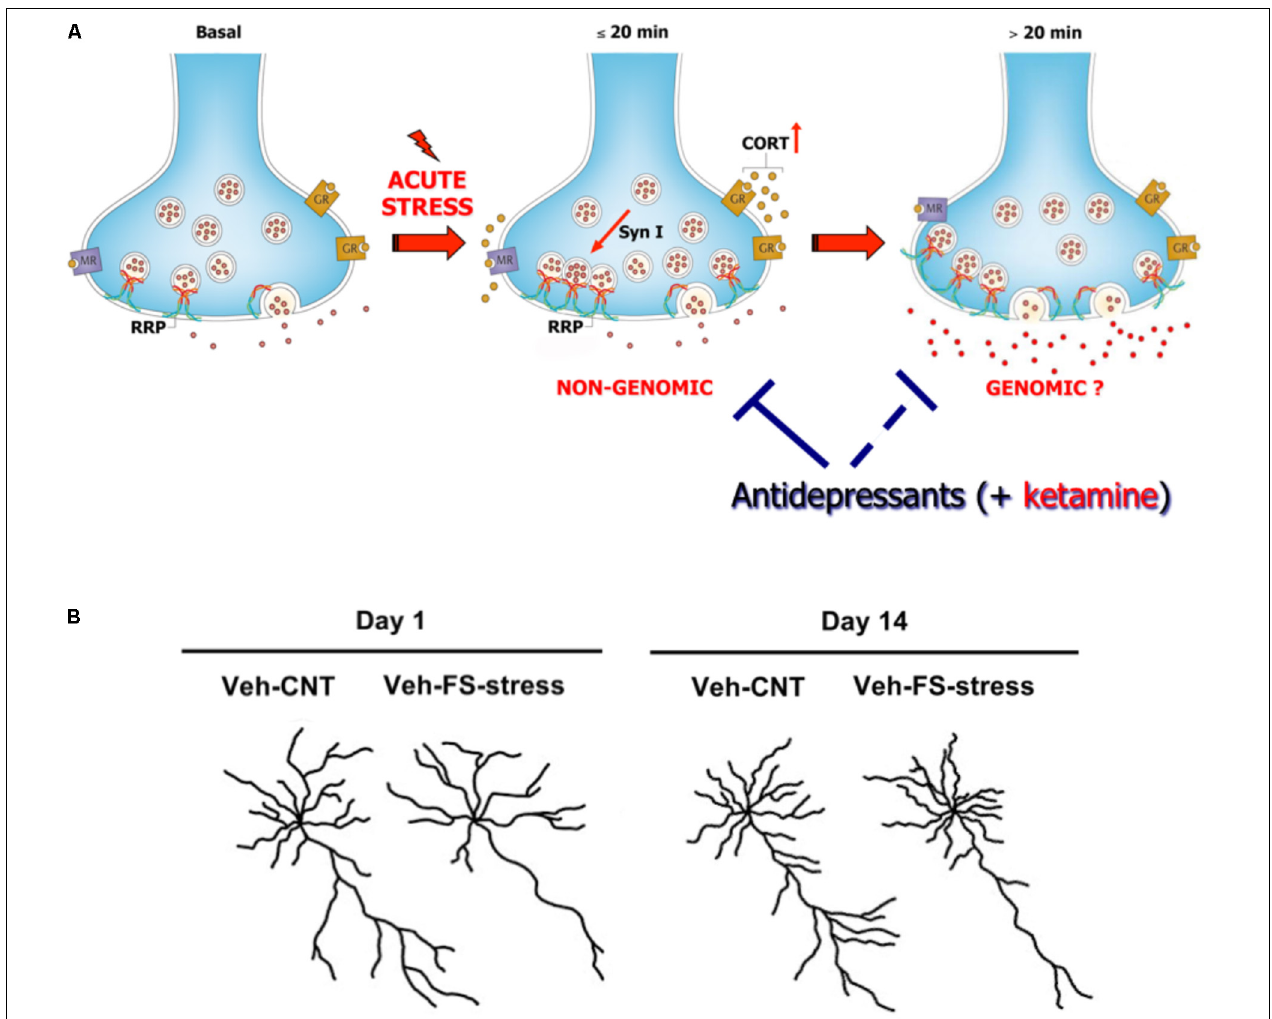
FIGURE 2 | (A) Acute stress increases circulating levels of CORT that binds to local synaptic mineralocorticoid/glucocorticoid receptors. This in turn induces, in synaptic terminals of prefrontal and frontal cortex, a rapid increase of vesicle trafficking into the readily releasable pool (RRP) of glutamate vesicles, with consequent increase of RRP size ( < 20 min). This implicates non-genomic mechanisms, in particular phosphorylation of the presynaptic protein synapsin I at Ser 9 . The increase of RRP size, rapidly induced by CORT, primes the terminals for the subsequent enhancement of depolarization-evoked glutamate release. This was shown by in vitro incubation of purified synaptic terminals (synaptosomes) with CORT, which replicates the increase in the size of glutamate RRP and synapsin I phosphorylation. Slower ( > 20 min), perhaps partly genomic, effects are required to promote the enhancement of glutamate release and excitatory transmission induced by acute stress. The acute stress-induced enhancement of glutamate release is blocked by previous chronic treatment with antidepressants (but also by acute ketamine treatment, see below). Antidepressants block the buildup of RRP, but likely also act on subsequent events leading to glutamate release enhancement. Modified from Treccani et al. (2014b). (B) Representative reconstructions of prelimbic pyramidal neurons. Length of apical dendrites in layer II/III prelimbic PFC was significantly reduced 1 and 14 days after acute FS stress. Veh-CNT, control animals; Veh-FS-stress, FS stressed animals. Modified from Musazzi et al.